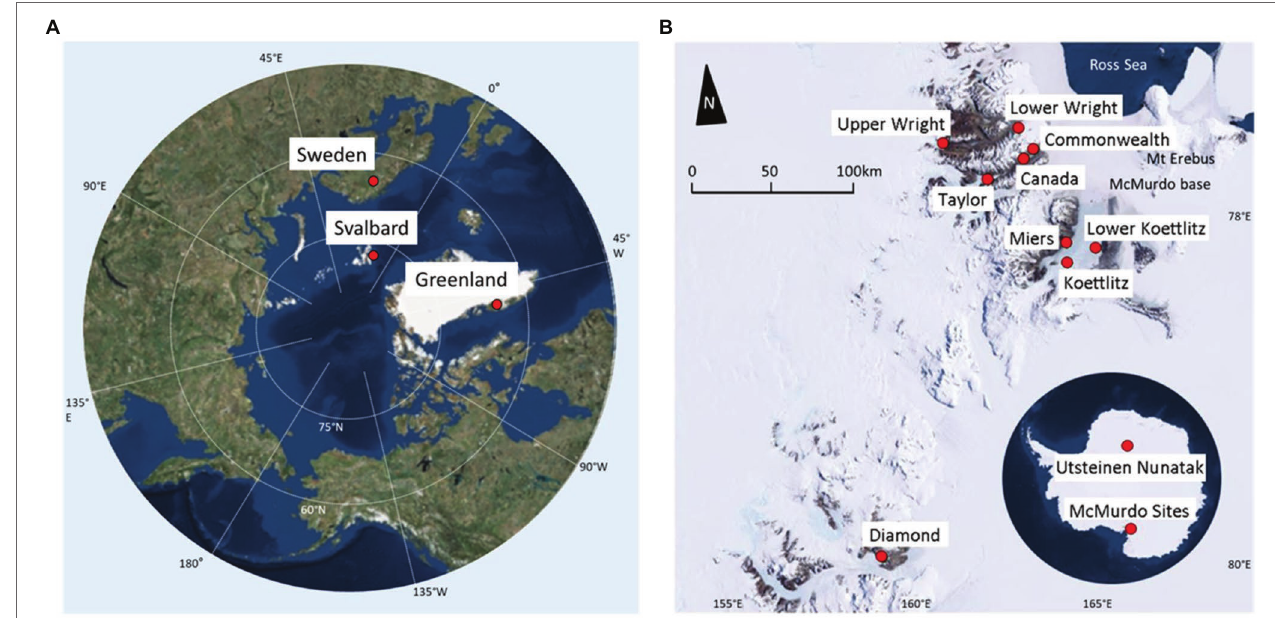
FIGURE 1 | Sampling locations. (A) Arctic map, highlighting regions sampled. Points marked indicate sample site locations and names. (B) Map of Antarctic sampling locations. Antarctic continental map highlighting the Utsteinen Scoop and the McMurdo Dry Valleys. Underlying is a McMurdo Valleys map, which shows a detailed view of those sites. Base maps were created using ArcGIS® software by Esri. ArcGIS® and ArcMap ™ are the intellectual property of Esri and are used herein under license. Source: ArcWorld